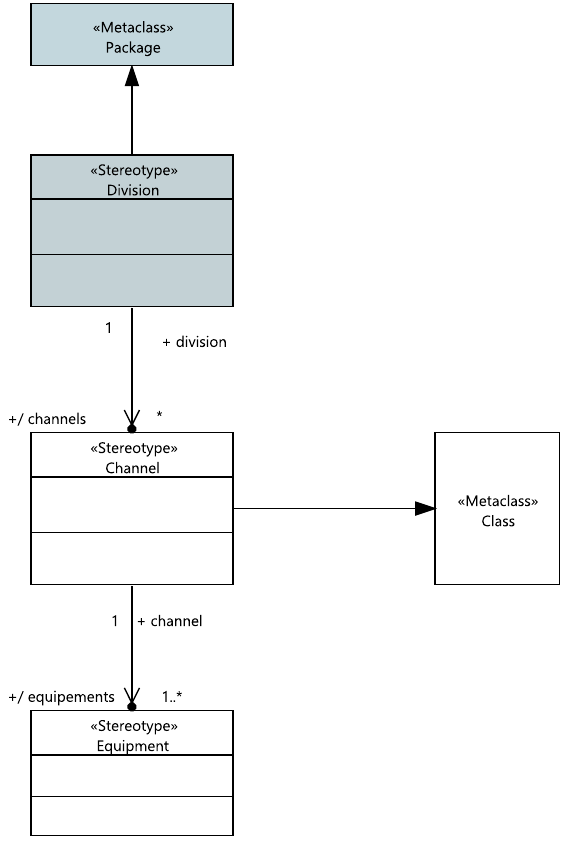
Figure 11. Meta-model of divisions and